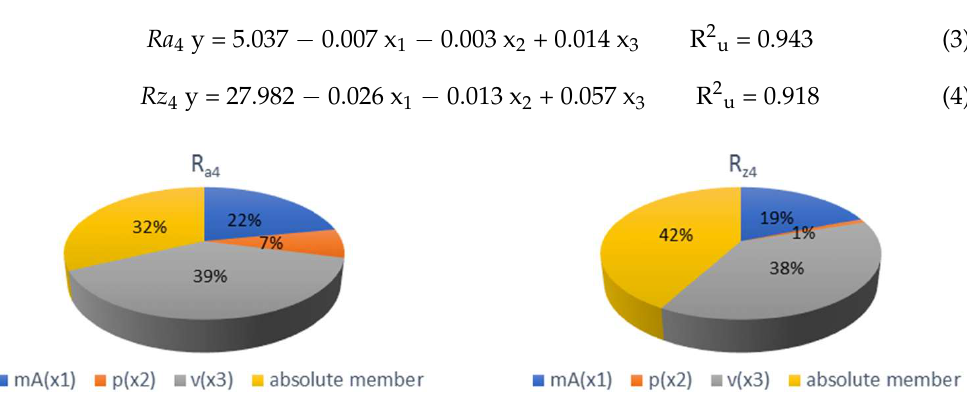
Figure 13. Graph of significance of mathematical model parameters for Ra 4 and Rz 4 roughness parameters.